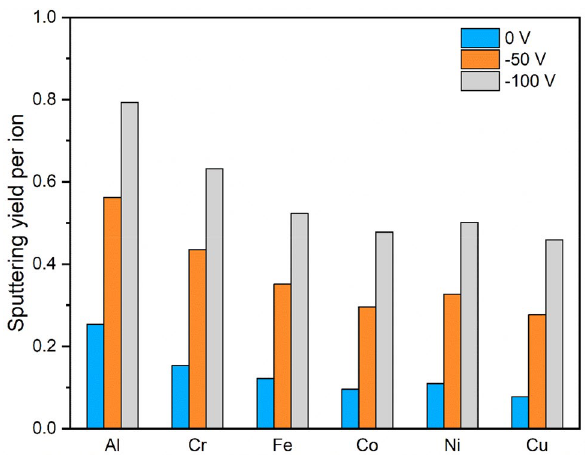
Figure 2. Sputtering yield per ion of deposition for each element with the substrate bias of 0 V, −50 V, and −100